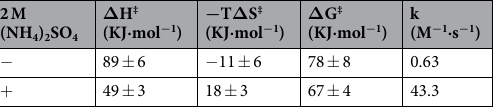
Table 1. Influence of ammonium sulfate on thermodynamic parameters (310 K) for the arylation reaction between peptide 1 A and probe 2